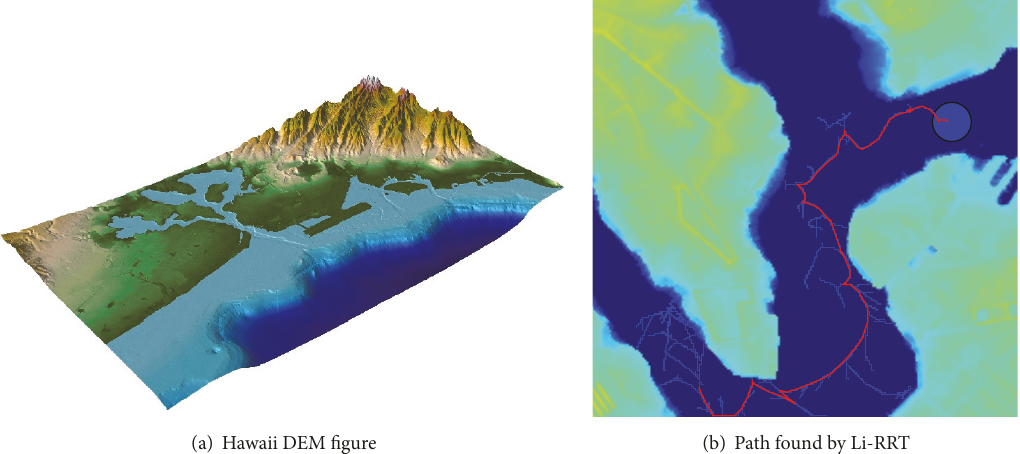
Figure 7: Start position locates at 157 ∘ 58 󸀠 30 󸀠󸀠 W, 21 ∘ 20 󸀠 29 󸀠󸀠 N; goal locates at 157 ∘ 57 󸀠 47 󸀠󸀠 W, 21 ∘ 21 󸀠 14 󸀠󸀠 N, shown as a solid blue circle. Red line describes a valid path from start to goal.